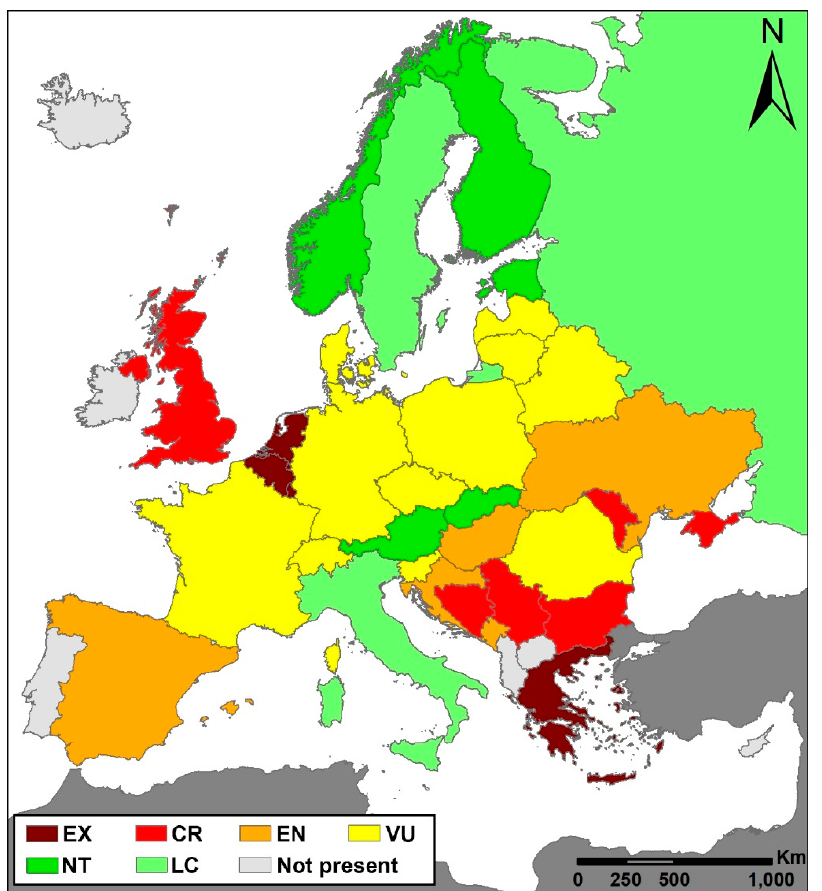
Figure 1. Map of Europe presenting the IUCN threat category of Cypripedium calceolus in each country. The map was created using the projected coordinate system “Lambert_Azimuthal_Equal_Area”.